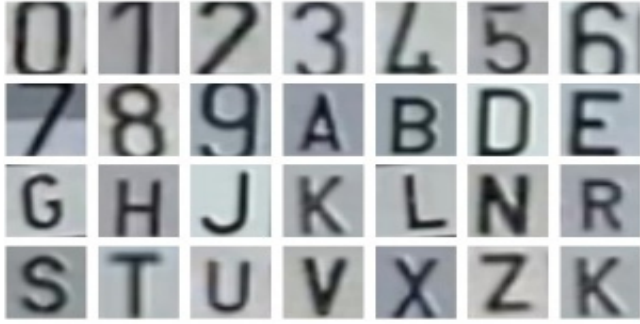
Figure 4. Examples of some alphanumeric classes’ samples.